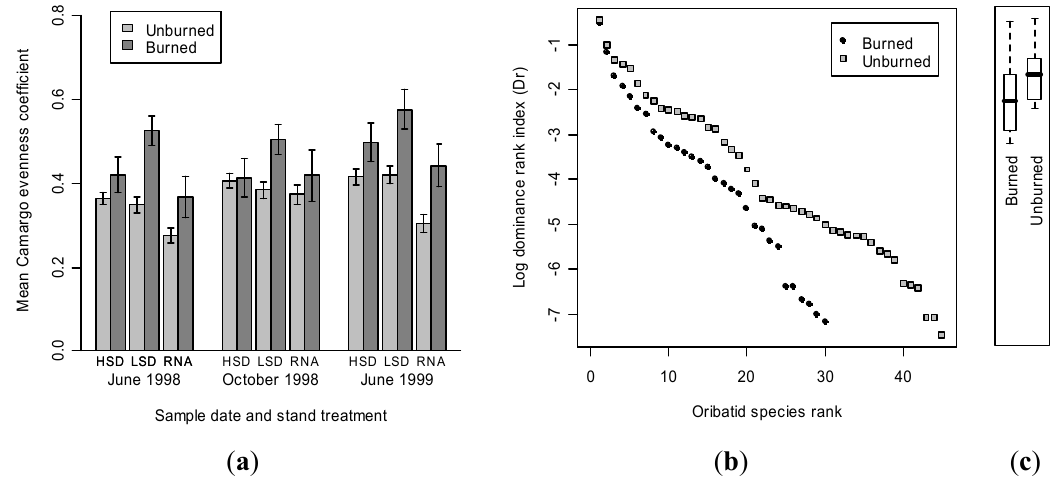
Figure 6. ( a ) Mean oribatid mite species assemblage evenness (Camargo index) ± SE, in unburned and burned split-plots from high structural diversity treatment plots, low structural diversity treatment plots, and the RNAs during each of the three sampling periods (June 1998, October 1998, and June 1999); ( b ) Dominance-rank curves for the pooled burned and unburned split-plots and RNAs. Each point represents the species rank ) for a specific oribatid taxon; ( c ) Box and whisker plots for the top 10 ordered log( D r ranked taxa in the burned and unburned groups shown in ( b ) representing the positions of ), the second and third quartiles of the log( D ) distribution, and the the median log( D r 10 r 10 full range of observed log( D r 10